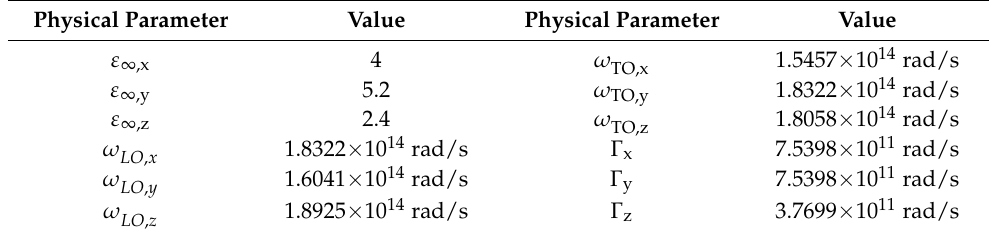
Figure 1. The metasurface structure with spin thermal radiation; both substrate and rectangular strips are α -MoO 3 . Table 1. Values and parameters of the